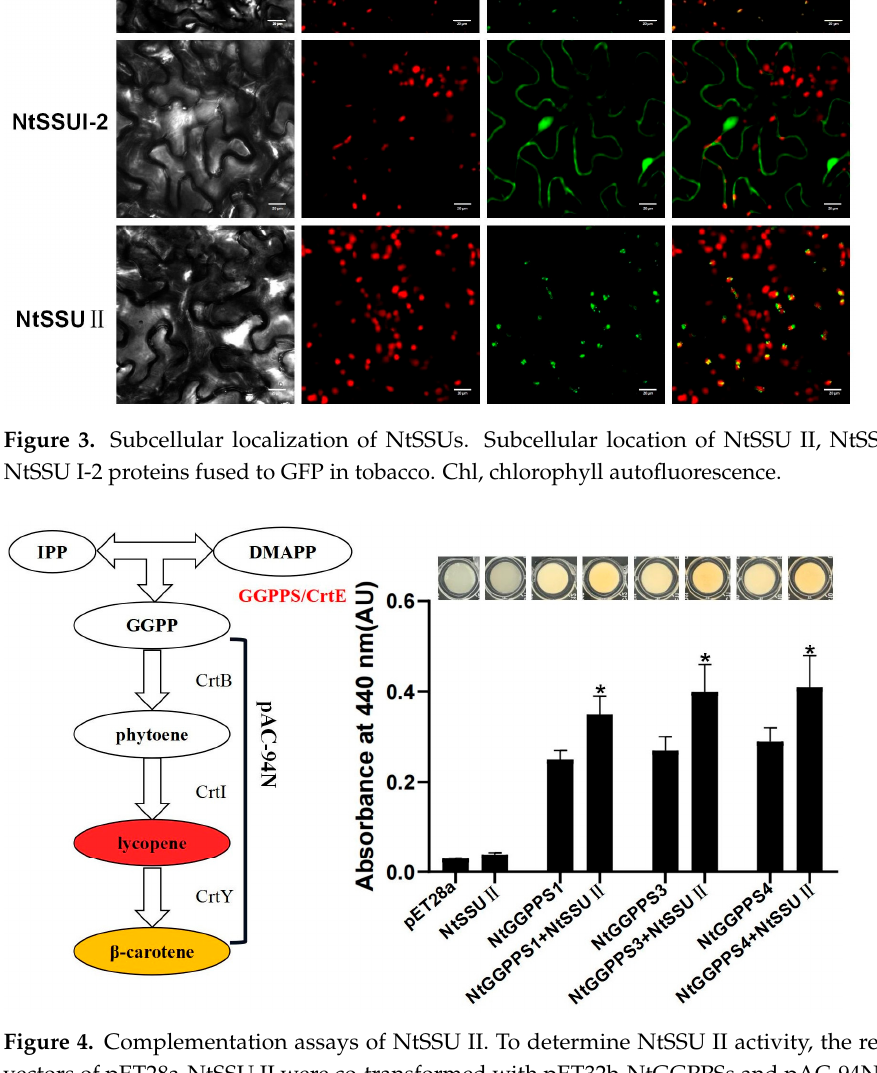
Figure 4. Complementation assays of NtSSU II. To determine NtSSU II activity, the recombinant vectors of pET28a-NtSSU II were co-transformed with pET32b-NtGGPPSs and pAC-94N into E. coli BL21(DE3) cells, using empty pET28a as negative control. The absorbance at 440 nm was used to estimate the quantity of β -carotene. Asterisks represent statistically significant differences between pET32b-NtGGPPSs and pET32b-NtGGPPSs co-transformed with pET28a-NtSSU II determined by Student’s t-test (*, p < 0.05).